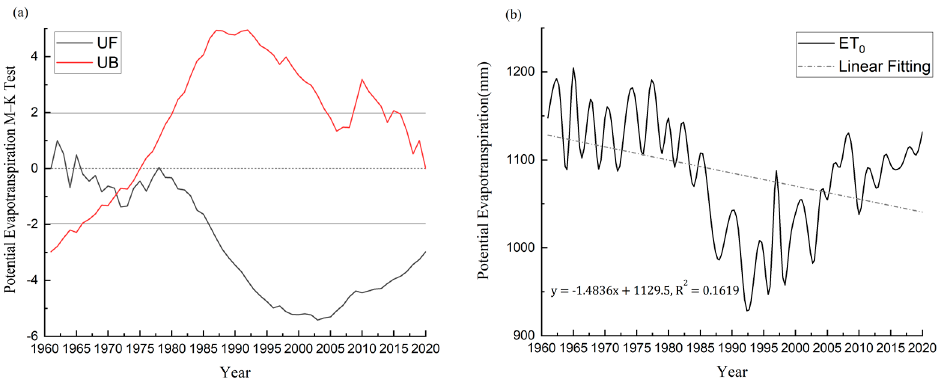
Figure 6. M − K mutation test ( a ) and trend analysis of the potential evapotranspiration ( b ) in Xinjiang.